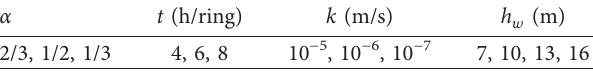
Figure 10: Measured and calculated values of the water seepage volume. Table 3: Seepage model parameters.